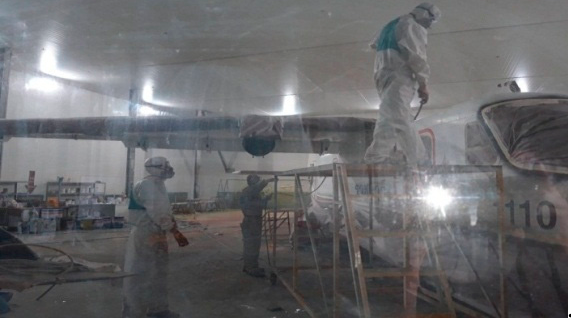
Figure 5. RTN painting’s work.